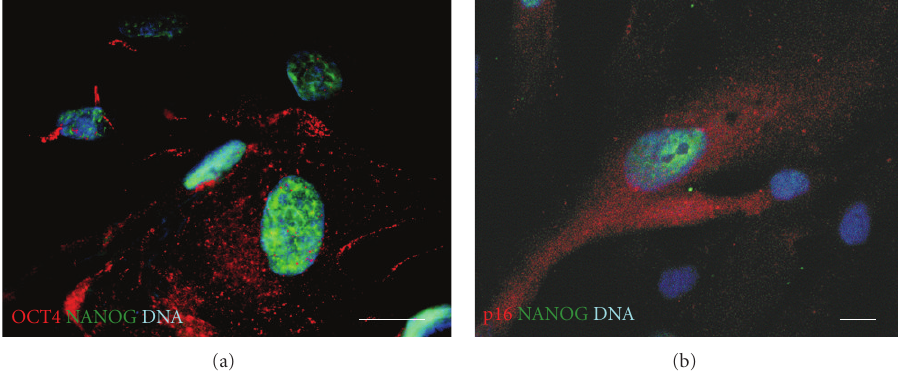
Figure 5: Examples of pre-senescent IMR90 fibroblasts grown on the coverslip, which di ff er from the surrounding cells by enlarged nuclei, cytoplasm volume, and the tendency of flattening. These cells express: (a) enhanced OCT4 (mostly in cytoplasm) and nuclear NANOG and (b) paranucleolarly localized NANOG, which is combined with enhanced expression of the senescence regulator, p16. Both, self-renewal and senescence regulators are undetectable or at the background level in the neighbouring fibroblasts possessing small nuclei. Scale bars = 10 μ m. On (a) OCT4 was stained with the antibody for both A and B isoforms (Abcam polyclonal antibody, see Table